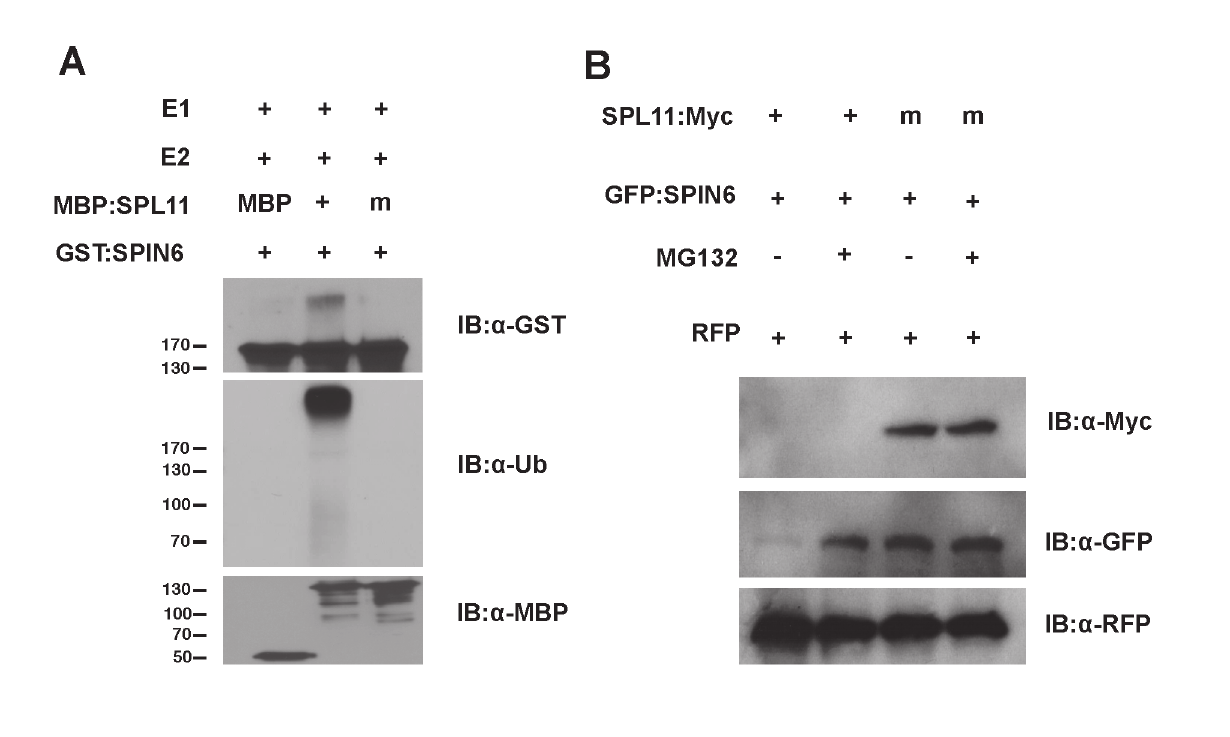
Figure 2. Ubiquitination of SPIN6 in vitro and degradation of SPIN6 in N . benthamiana by SPL11. (A) In vitro ubiquitination of SPIN6 by SPL11. The ubiquitination of GST:SPIN6 by MBP:SPL11 and the E3 ligase activity of SPL11 were detected by immunoblot with the anti-GST antibody and anti-ubiquitin antibody, respectively, in the presence of Arabidopsis E1 (At5g06460), E2 (AtUBC10, At5g53300) and ubiquitin. MBP and mutated SPL11 without E3 ligase activity (SPL11m) fused with MBP were used as the negative controls. Immunoblot with anti-MBP antibody was conducted as a loading control. (B) Degradation of SPIN6 promoted by SPL11 in N . benthamiana . Either SPL11:Myc or SPL11m:Myc was co-expressed with GFP:SPIN6 by agro-infiltration in N . benthamiana . Tissues were harvested at 3 days after the infiltration. MG132 (50 μ M), an inhibitor of 26S proteasome system, was infiltrated at 18 h before sampling with DMSO (-) as a control. RFP was expressed as an internal control. SPL11 but not with SPL11m (Figure S8A in S1 Text, second lane in the first panel) and that the ubiquitinated GST:SPIN6 was only detected by the anti-ubiquitin antibody only in the reaction with the wild-type SPL11 (Figure S8A in S1 Text, second lane in the second panel). These re- sults clearly indicate that SPIN6 is ubiquitinated by SPL11 in vitro . To investigate whether the ubiquitination of SPIN6 by SPL11 can lead to instability of SPIN6 in vivo , we co-infiltrated different combinations of agrobacteria carrying the Spl11 : Myc and GFP : Spin6 plasmids into N . benthamiana leaves with or without the 26S proteasome inhib- itor MG132. Total protein was extracted 3 days after the infiltration, and MG132 was infiltrated into the same leaves 18 h before tissue collection. The immunoblot analysis revealed that the GFP:SPIN6 was degraded by SPL11:Myc (Fig. 2B, lane 1 in the second panel) but that the SPIN6 degradation was inhibited by MG132 (Fig. 2B, lane 2 in the second panel). In contrast, SPIN6 was not degraded when the mutated Spl11m : Myc plasmid without E3 ligase activity was expressed with or without the MG132 treatment (Fig. 2B, lane 3 and 4 in the second panel). The SPL11:Myc fusion protein was not stable in N . benthamiana with or without MG132 treatment (Fig. 2B, lane 1 and 2 in the first panel), probably due to self-ubiquitination. Howev- er, the SPL11 fusion protein was slightly visible when the immunoblot was overexposed for 15 min (Figure S8B in S1 Text, second lane in the first panel) and it was clearly visible for over 20 min (Figure S8B in S1 Text, second lane in the second panel).